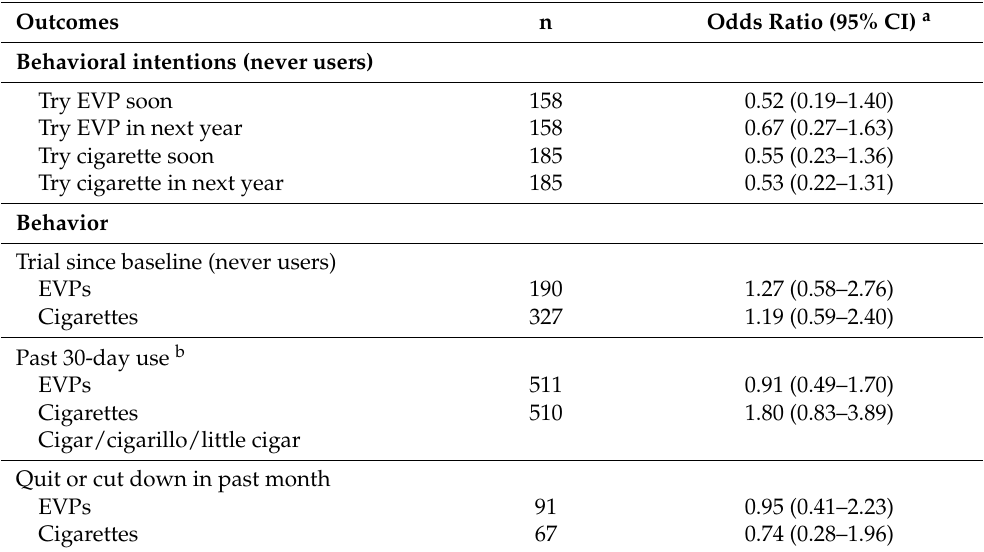
Table 4. Effect of study condition on behavioral intentions and behavior at 1-month follow-up,